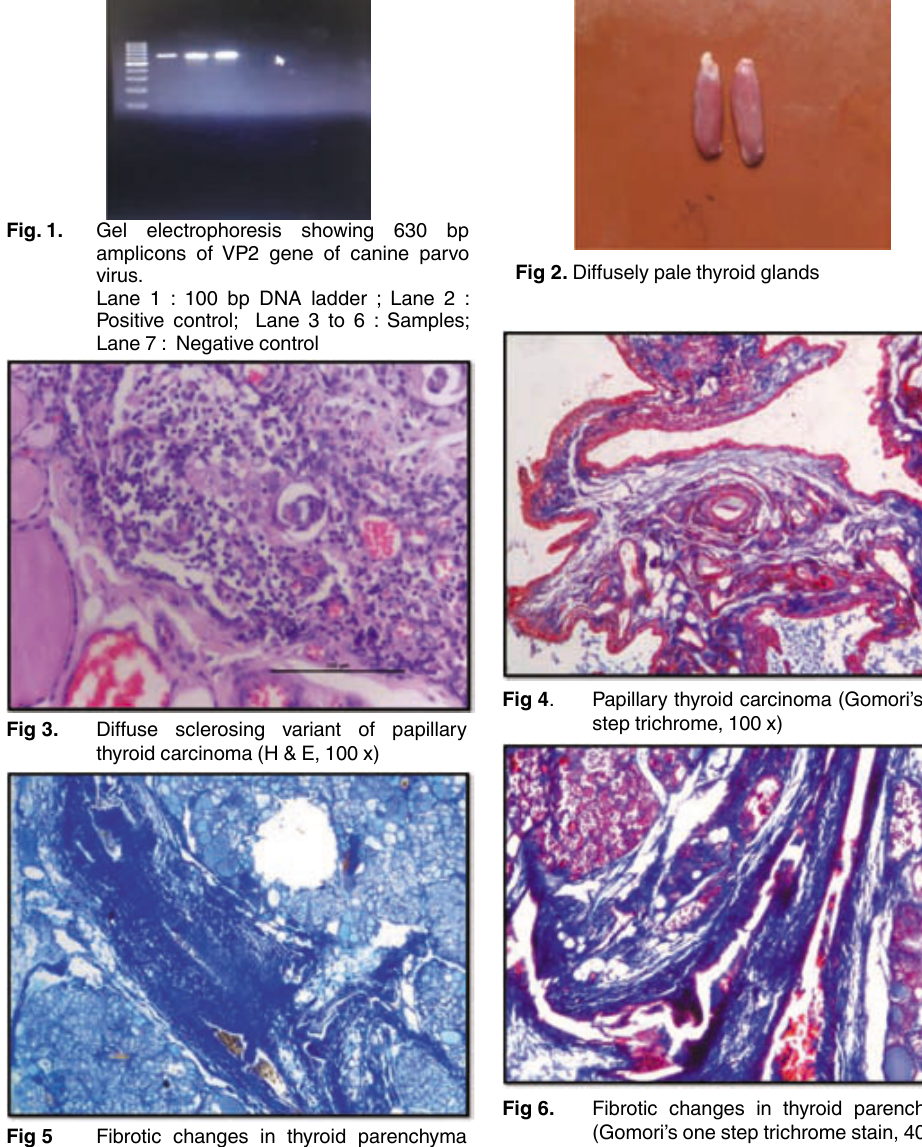
Fig 5 Fibrotic changes in thyroid parenchyma (Mallory’s stain, 100 x)